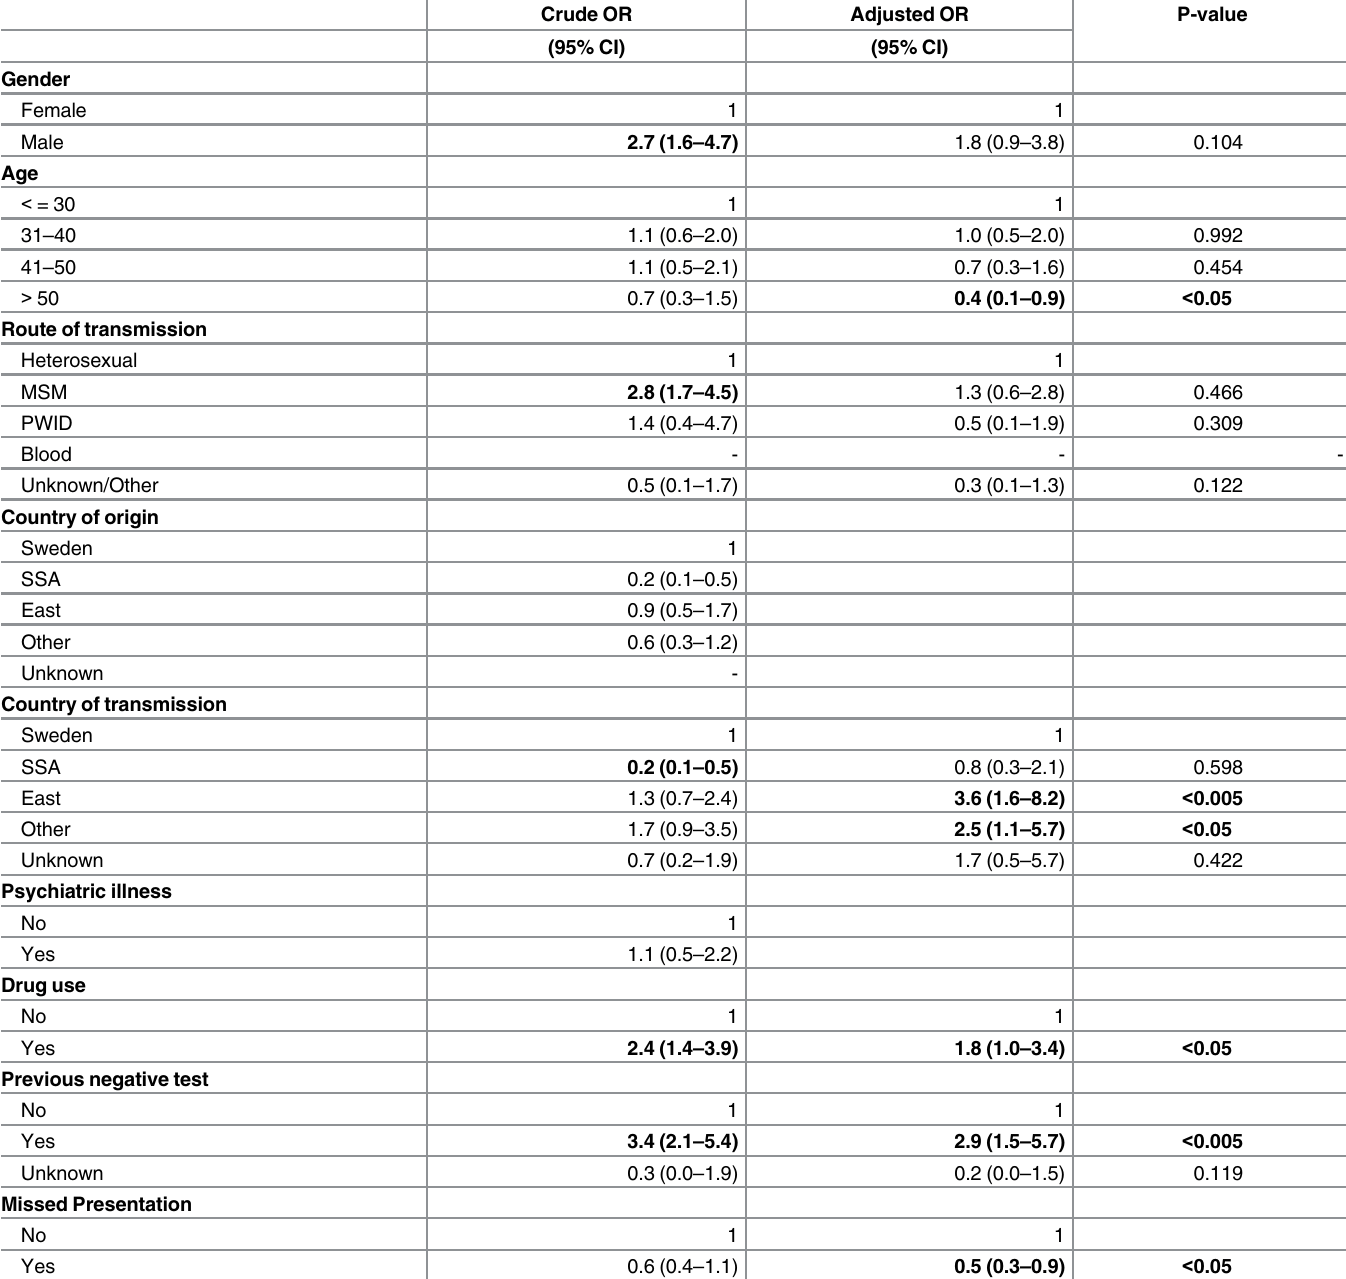
Table 2. Bivariate and multivariable logistic regression models for the patient as the initiator of the HIV-test in 409 newly diagnosed patients. CI, confidence interval; OR, odds ratio; MSM, men who have sex with men; PWID, people with injecting drug use; SSA, sub-Saharan Africa; ‘ East ’ , EasternEu- rope, Asia and the Pacific region; ‘ Other ’ , Western Europe, North and Latin America, the Caribbean, North Africa, Israel and the Middle East. Significant results are shown in bold. Crude